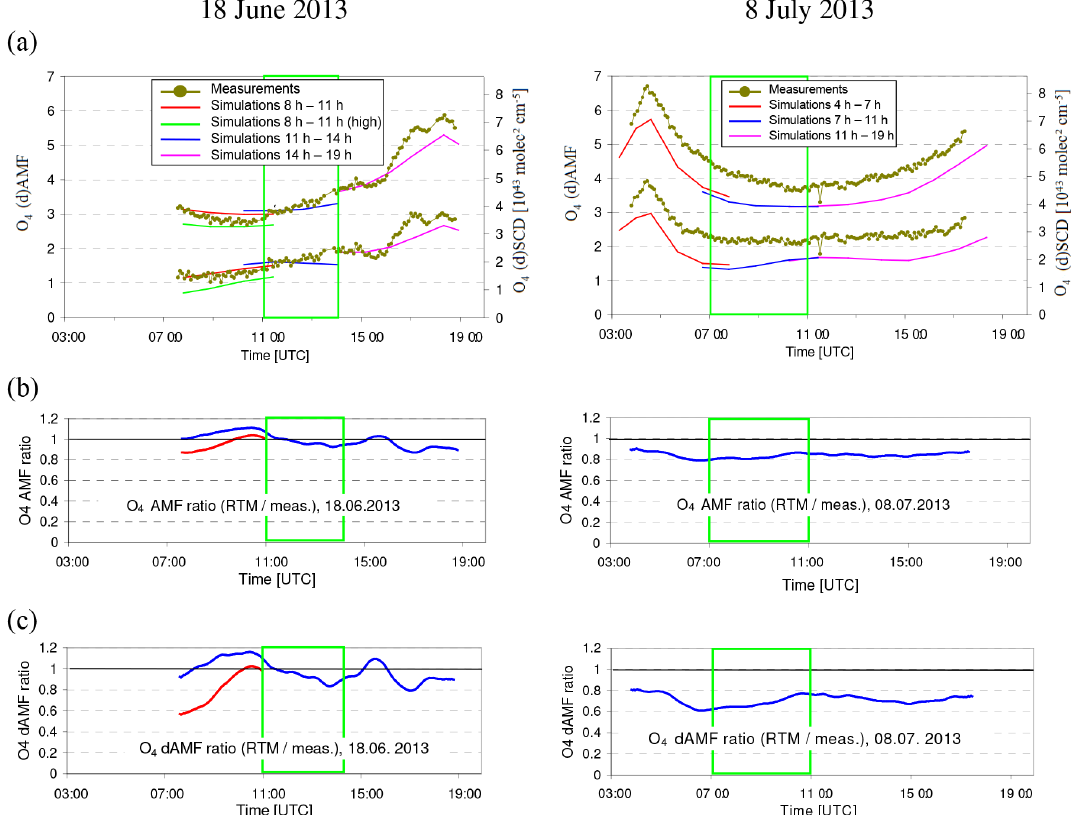
Figure 3. (a) Comparison of O 4 (d)AMFs from MAX-DOAS measurements and forward model simulations for the 2 selected days. The green rectangle indicates the middle period on each day, which are the focus of the quantitative comparison. The green line on 18 June represents forward model results for a modified aerosol profile (see text). The y axis on the right shows the corresponding O 4 (d)SCDs for O 4 VCDs of 1 . 23 × 10 43 molecules 2 cm − 5 and 1.28 · 10 43 molecules 2 cm − 5 for 18 June and 8 July, respectively (see Sect. 4.1.2). In (b) and (c) the ratios of the simulated and measured AMFs and dAMFs are shown, respectively. The red line on 18 June represents the ratios for the modified aerosol